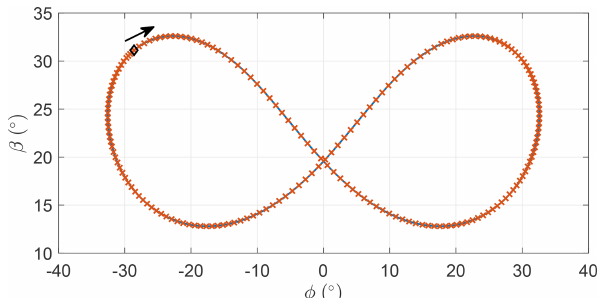
Figure B3. Azimuth and elevation of the trajectory found with the harmonic balance method and the time integration scheme for a figure-of-eight-shaped trajectory.